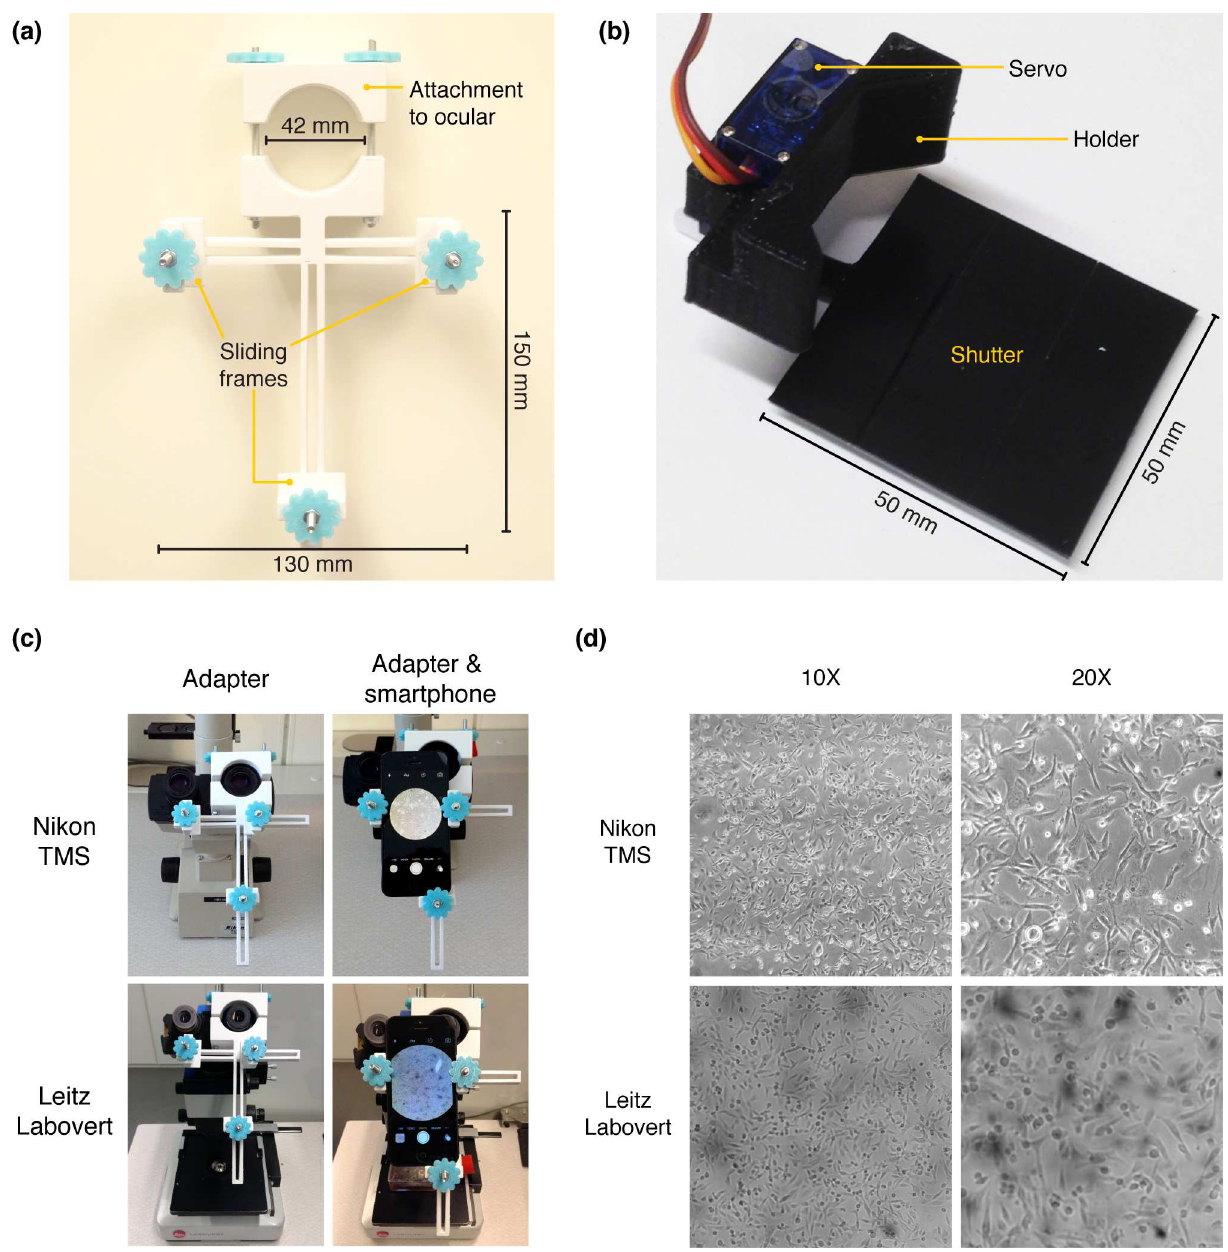
Fig 2. Imaging module. (a) The smartphone holderwas designed to allow for stable fixation of most currently existing smartphones to microscopeshaving ocularsof up to 42 mm in diameter. Slidingframes (that could be fixed by fasteningthe nut in each frame) in the holder facilitatedthe alignmentof the smartphone’s camera to the ocular. (b) The shutter was built from a servomotor, a plastic shutter disc, and a 3D-printedconnector. The servomotor was used to openor close the shutter in responseto commandsfrom the control unit. (c) Examplesof two different microscopesfitted with the smartphone holderand an iPhone5. (d) Images of MDA-MB-231 breast cancer cells capturedwith an iPhone5 and the smartphone holderusing the 10X- and 20X-objectivesof each